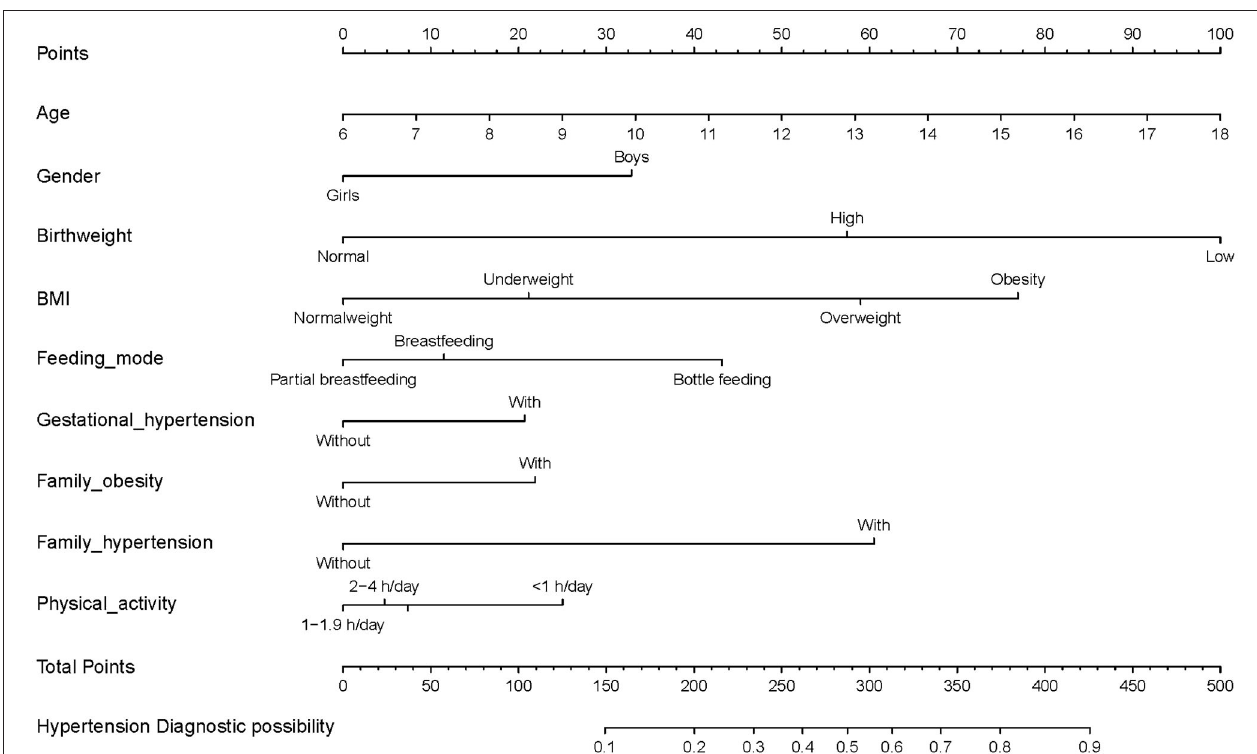
FIGURE 2 | Clinical nomogram for predicting probability of developing HBP among children and adolescents, and its predictive performance. To use the nomogram, an individual HBP contact’s values are located on each variable axis, and a line is drawn downward to the risk of HBP axes to detect the hypertension probability. As an example of how this nomogram can be calculated, we can take an 18-year-old obese boy who was bottle-fed in early life, with gestational hypertension, family history of hypertension and obesity, and < 1-h physical activity expenditure. By drawing a line up toward the points for each of the variables this student will have 100 points (age), 32 points (gender), 74 points (BMI status), 42 points (feeding mode), 20 points (gestational hypertension), 21 points (family obesity), 59 points (family hypertension), and 26 points (physical activity), giving a total of 374 points (at the bottom of the figure), and a probability of HBP of